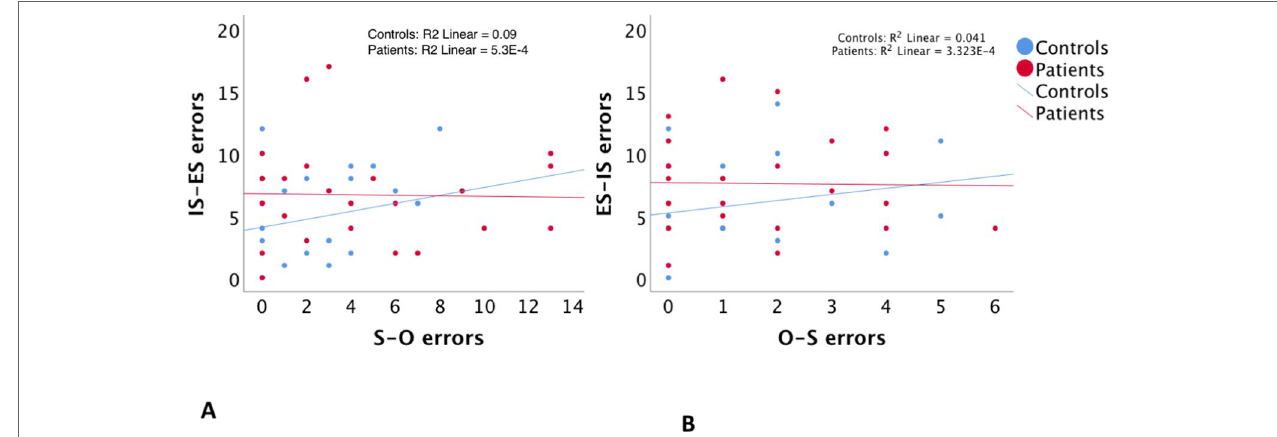
FIGURE 2 | The relationship between self–other misattribution errors (S–O errors) and internal space–external space misattribution errors (IS–ES errors) (A) , and between other–self misattribution errors (O–S errors) and external space–internal space misattribution errors (ES–IS errors) (B)